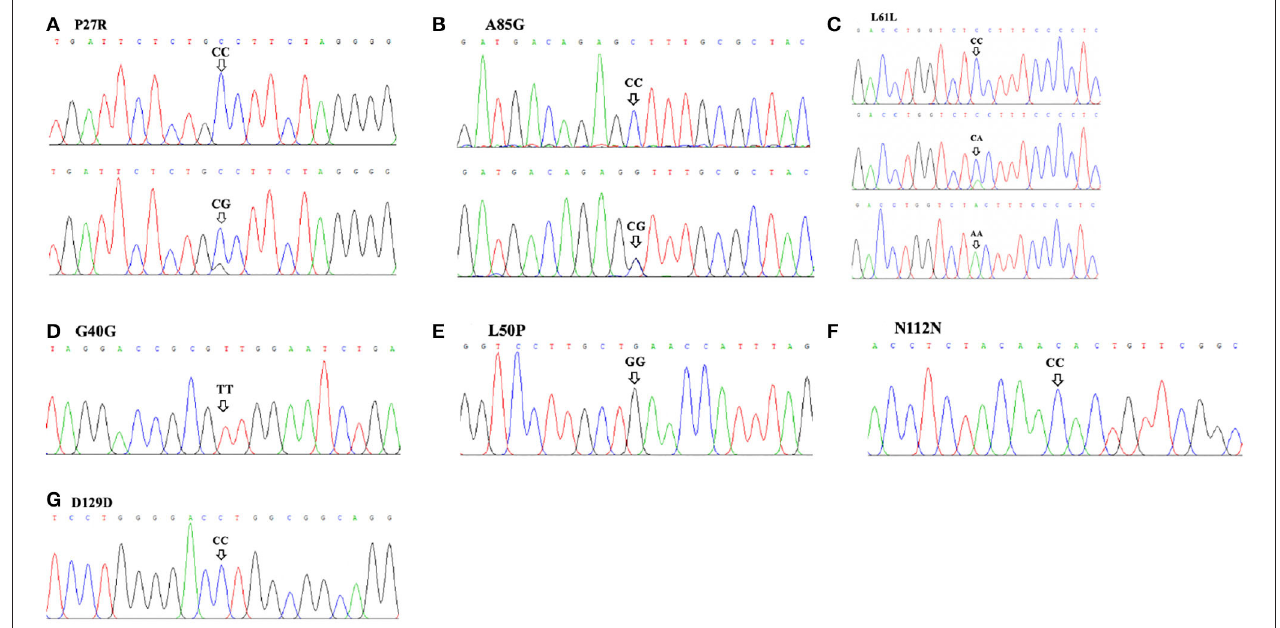
FIGURE 1 | Sequence chromatograms of seven SNPs in the goat GDF9 gene run on Chromas. (A) P27R; (B) A85G; (C) L61L; (D) G40G; (E) L50P; (F) N112N; (G) D129D.